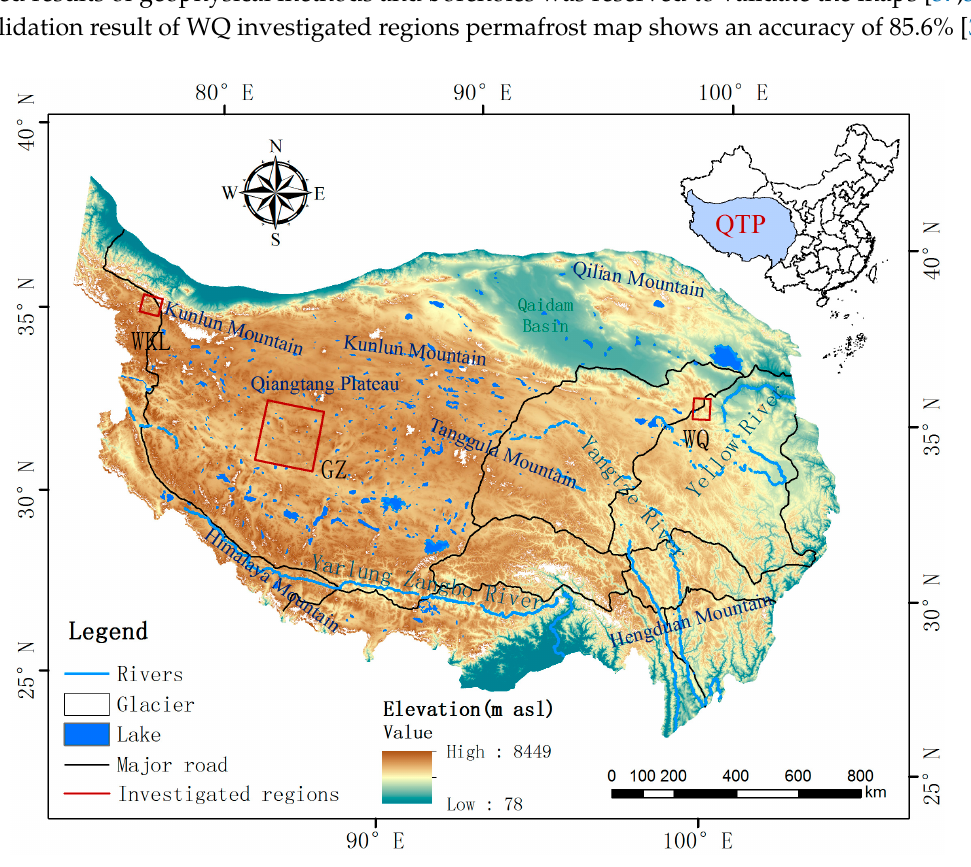
Figure 1. Spatial distribution of the field Investigated Regions (IRs) over the QTP.